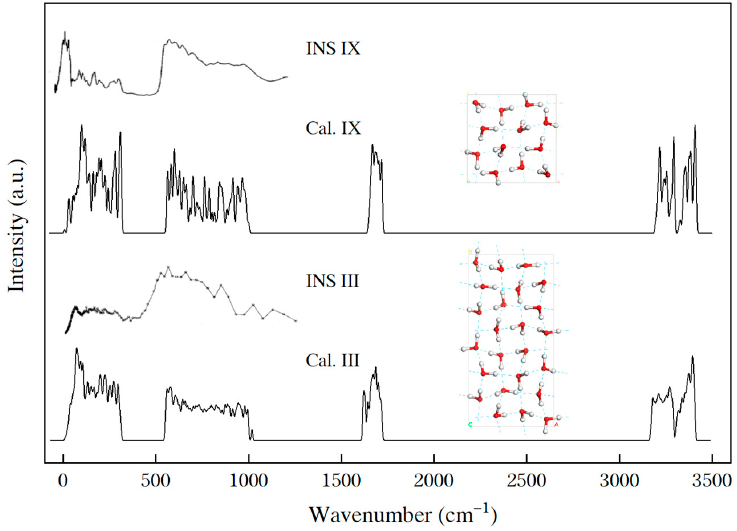
Figure 1. Comparisons of the experimental INS spectra (“INS”) [16,26] and the calculated PDOS curves (“Cal.”) of ices IX and III. The inserts show the structures of the primitive